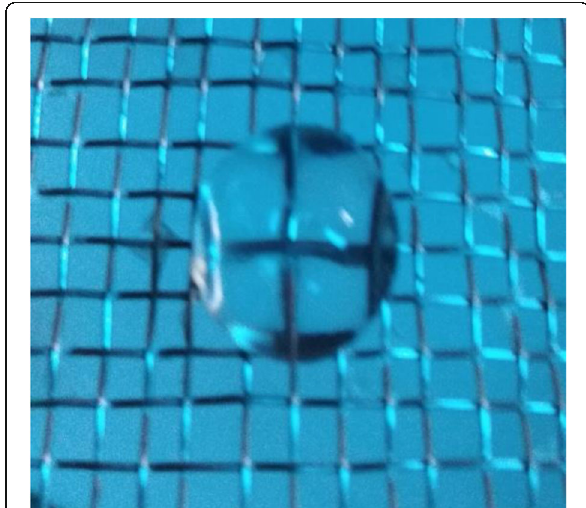
Fig. 10 Group I (normal control)